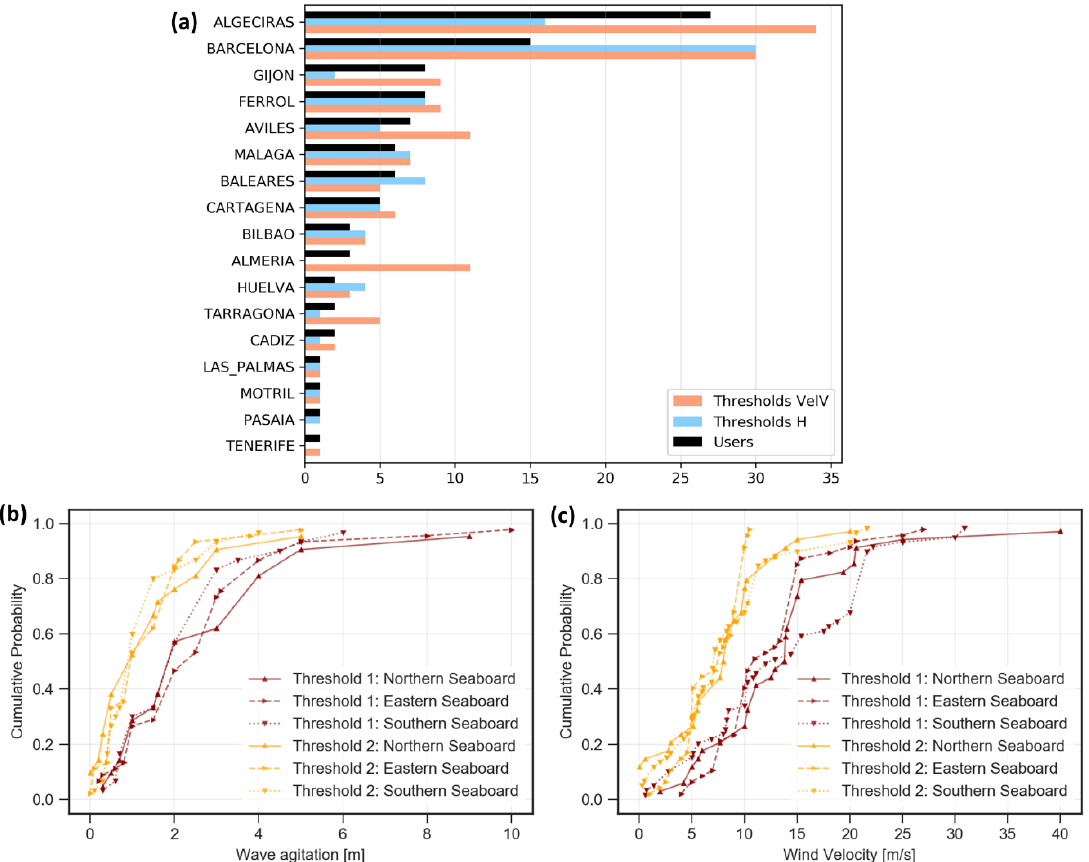
Figure 11. ( a ) Number of CMA users with customized thresholds for different Spanish State Ports, together with the total Points of Operational Interest (POIs) with customized thresholds for agitation (H) and wind velocity (VelV) inside the port (notice that users can customize as many POIs as available at each port); ( b ) Experimental Cumulative Density Function (CDF) of customized agitation thresholds for the Spanish State Ports sorted by seaboards. Threshold1 is related to a high vulnerability and Threshold2 to a mean vulnerability; ( c ) Experimental CDF of customized wind velocity thresholds for the Spanish State Ports sorted by seaboards. Threshold1 is related to a high vulnerability and Threshold2 to a mean vulnerability. Own elaboration, based on CMA database.